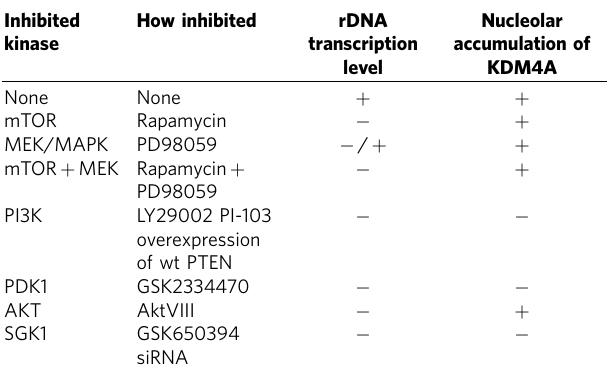
Table 1 | Effect of the inhibition of various serum-activated kinases on the activation of rDNA transcription and on the nucleolar localization of